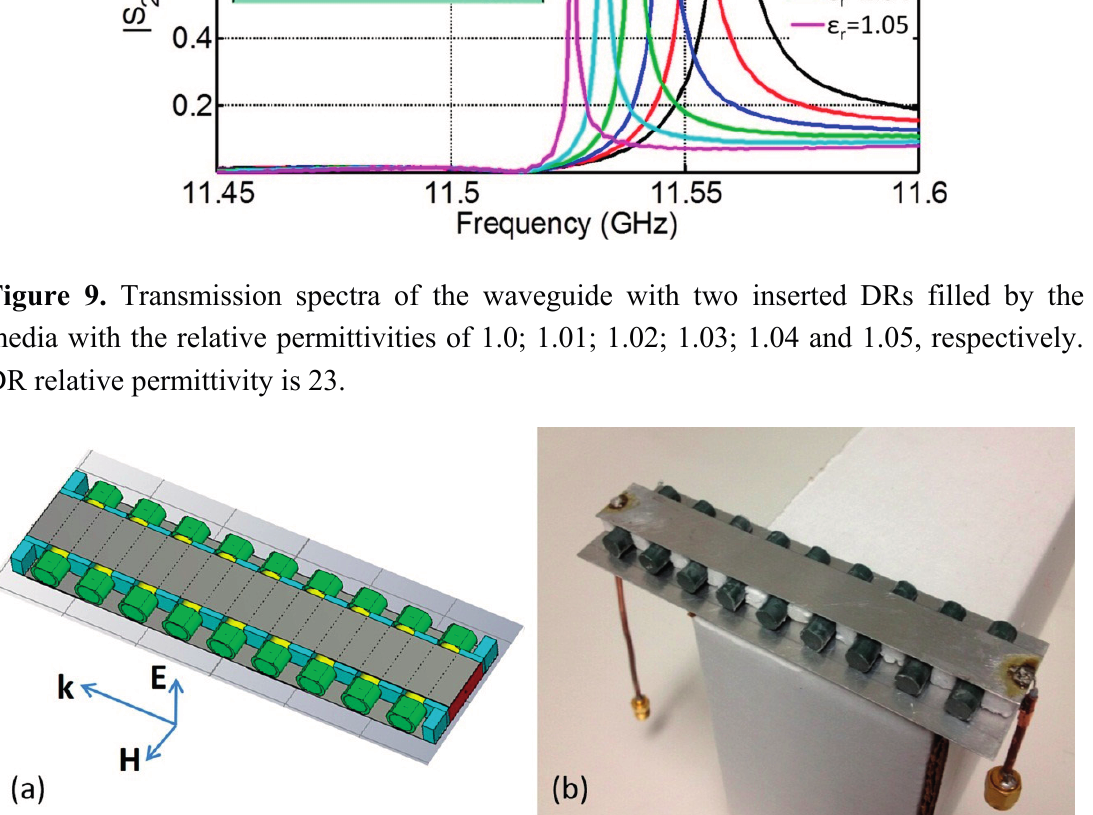
Figure 10. ( a ) Model of a microstrip line-fed sensor with rod array under the strip. Small amount of controlled substance is modeled by caps at the rod ends; ( b ) prototype of the microstrip line-fed sensor with rod array under the